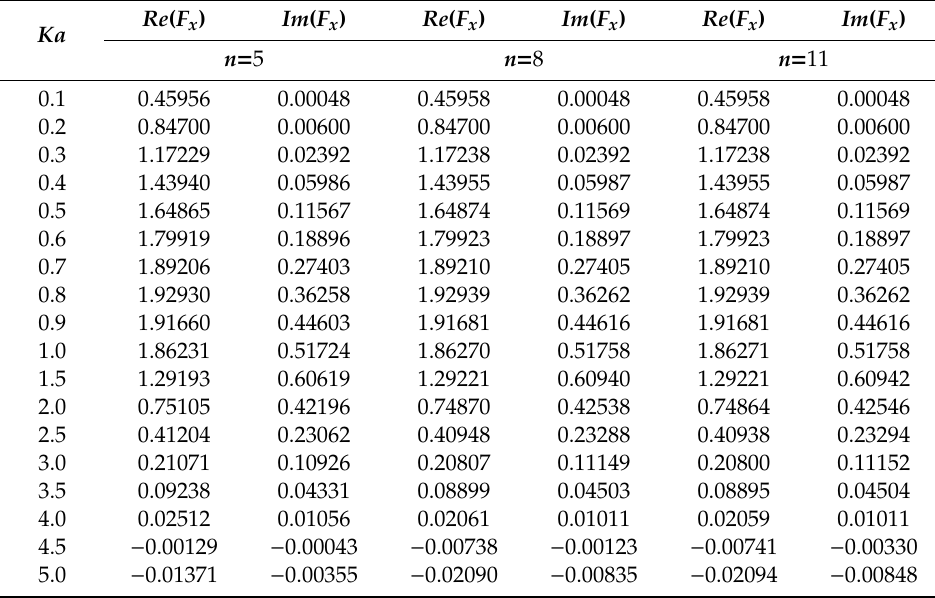
Table 1. Convergence sequence of the computations in terms of the real and imaginary parts of the normalized surge force F x / ρ gAa 2 for di ff erent mode numbers. Slenderness of the oblate spheroid is b / a = 0.8 with an immersion of f / a = 1.0. The normalization is that of Equation (43).